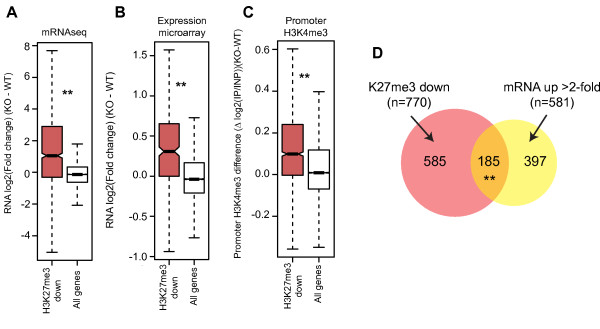
H3K27me3 loss in hypomethylated cells is associated with ectopic gene expression. (A, B) Boxplots displaying the relative expression (log2) of H3K27me3 down genes (red) and all genes (white) between Dnmt1+/+ and Dnmt1-/- MEFs as measured by mRNA-seq (A) and expression microarray (B). **P <0.001 by Wilcoxon rank sum test. (C) Boxplot showing the difference in promoter enrichment for H3K4me3 between Dnmt1+/+ and Dnmt1-/- MEFs as measured by ChIP-chip. **P <0.001 by Wilcoxon rank sum test. (D) Venn diagram showing overlap between H3K27me3 down genes (red circle) and genes that show >2-fold increased expression in Dnmt1-/- relative to Dnmt1+/+ MEFs by mRNA-seq (yellow circle). The number of genes in each section of the diagram is shown. **P <0.001 as estimated by hyper-geometric testing for the enrichment of the overlap genes.